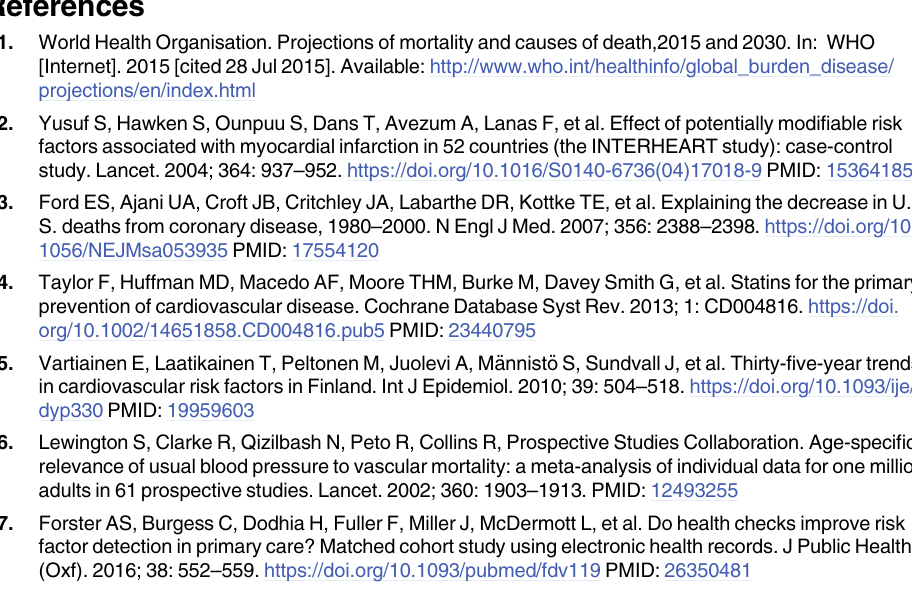
S1 Table. Classification of the degree of likeliness and likely timeline to undergo health checks. S2 Table. Summary results of pseudo-R 2 and test of parallel lines for four models. S3 Table. Correlation matrix for determinant variables in the